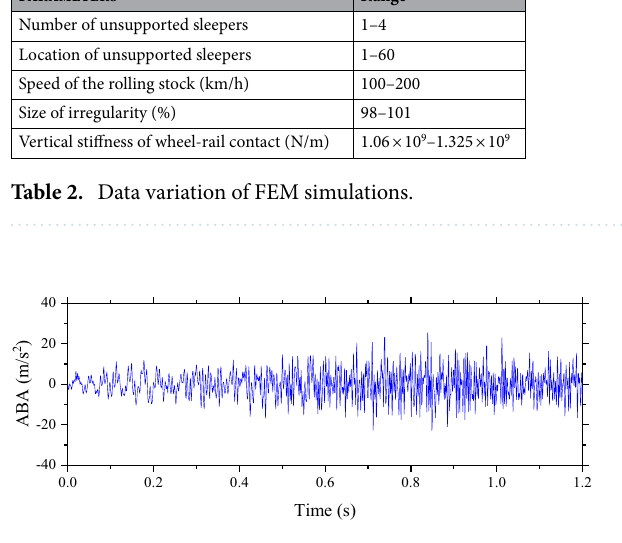
Figure 4. The ABA of the perfect condition when the speed is 100 km/h.